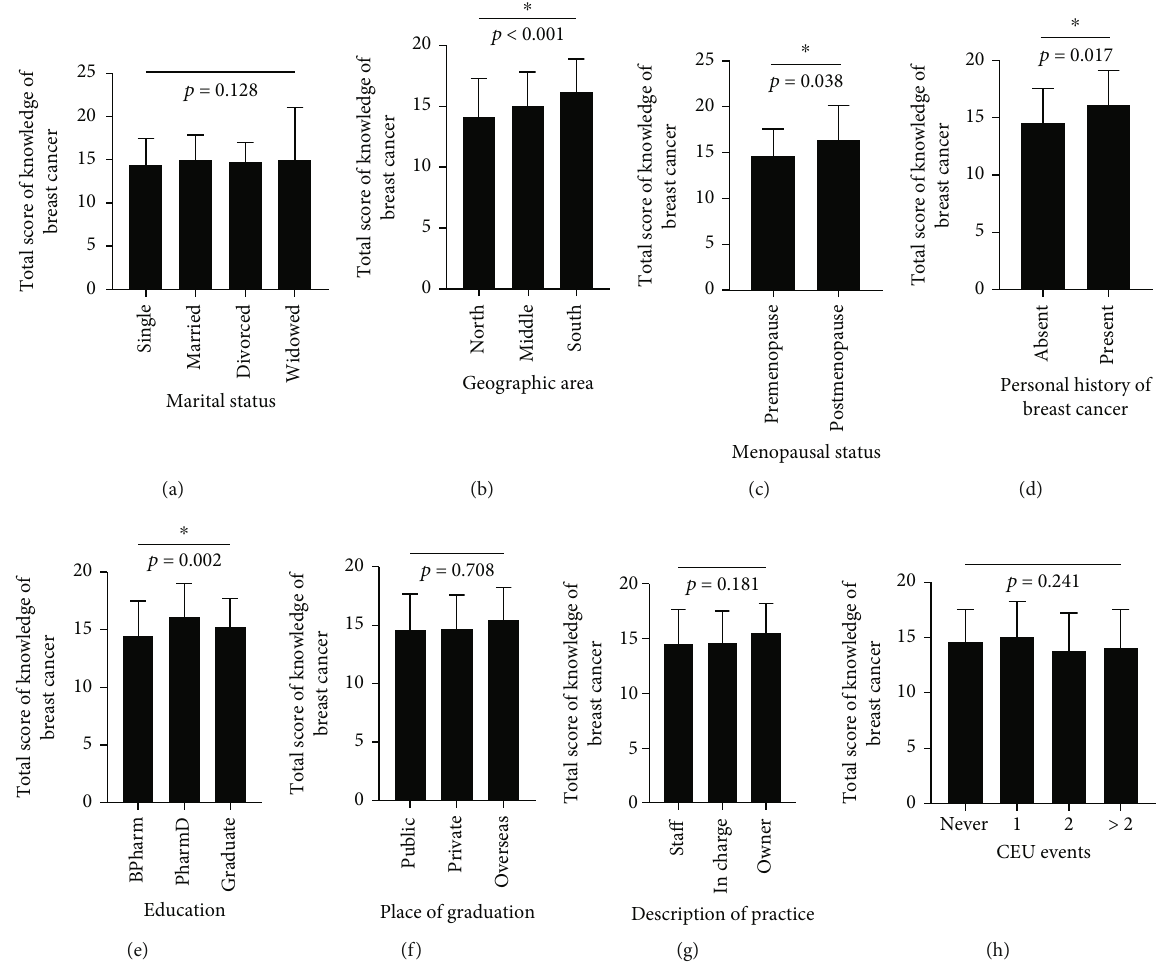
Figure 1: Knowledge of breast cancer based on demographic and practice characteristics of community pharmacists. Scores of breast cancer knowledge were compared according to (a) marital status, (b) geographic area, (c) menopausal status, (d) personal history of breast cancer, (e) education, (f) place of graduation, (g) description of practice, and (h) CEU events attended by community pharmacists. ∗ Indicates a statistically signi fi cant di ff erence at p < 0 : 05 . BPharm: Bachelor ’ s in Pharmacy; CEU: continuing education unit; PharmD: Doctor of Pharmacy